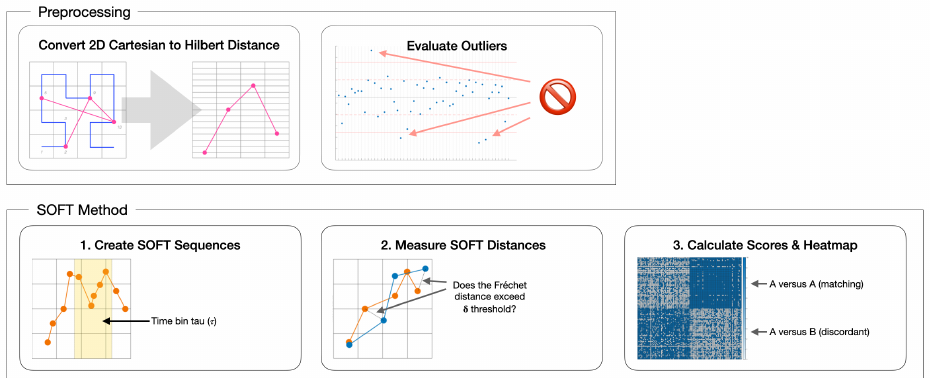
Figure 4. The sequences of fixations over time (SOFT)-Match scanpath comparison framework: The top block represents the preprocessing phase. The left square illustrates the conversion of the 2D pink scanpath data overlaid on a blue fractal curve path (left), with the arrow pointing to its converted data structure plotted as a pink line using x axis, time, and y axis, fractal curve position. The right square in the top block represents an outlier identification method developed by Newport et al. [37] where scanpaths exhibiting significant differences in geometric complexity are flagged for